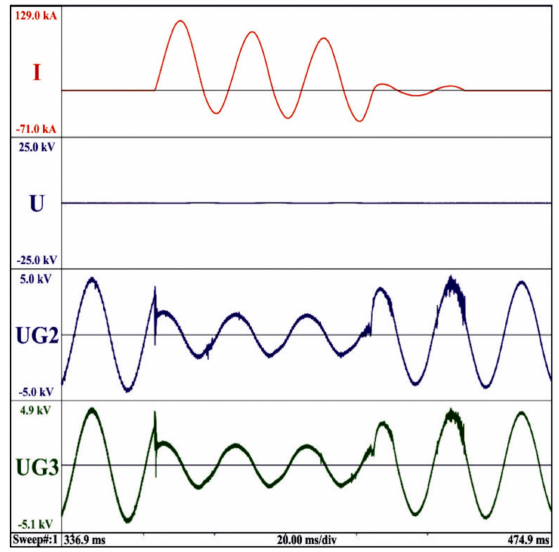
Figure 7. Oscillogram obtained during calibration for I 1